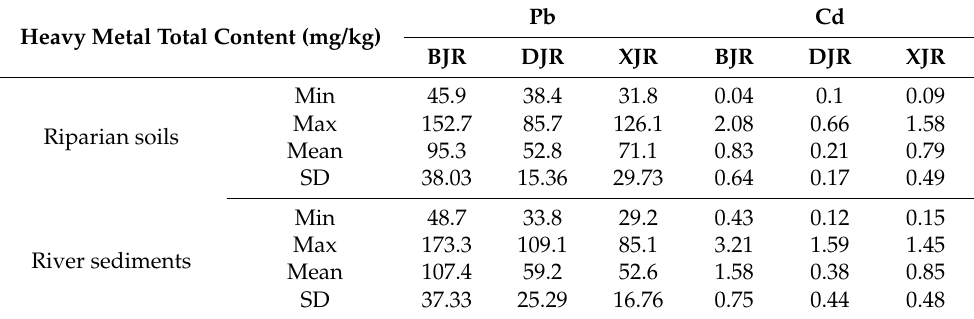
Table 1. Statistical summary of Pb and Cd contents in riparian soils and river sediments from BJR, DJR, and XJR